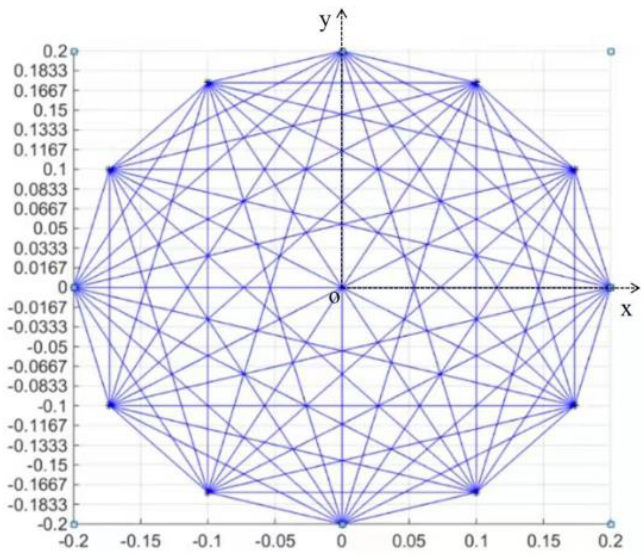
Figure 3. Pixel divisions and transducer locations.